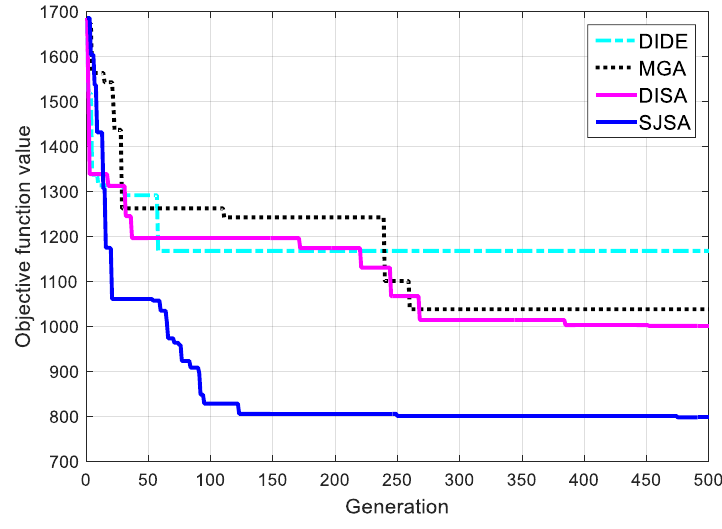
Figure 7. Convergence comparison in scenario